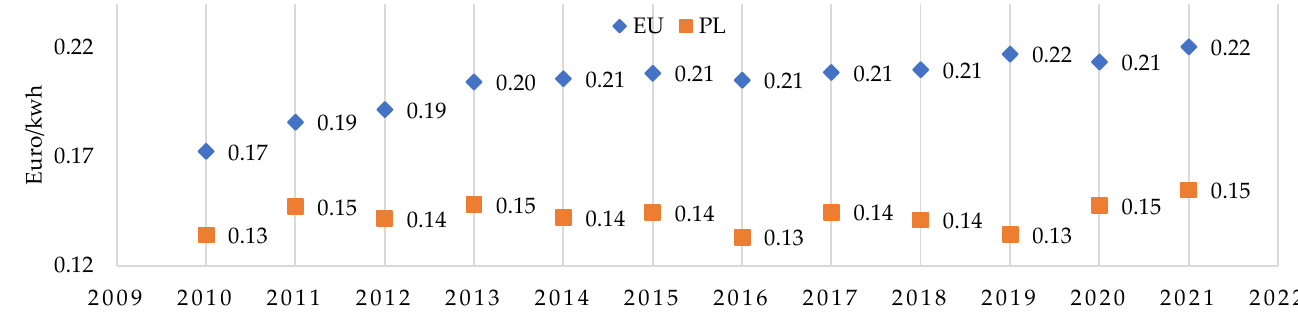
Figure 2. The structure of final energy consumption in households by type of fuel in Poland. Source: own elaboration based on EUROSTAT [40]. * Others—including: liquefied petroleum gases, ambient heat (heat pumps), other kerosene, solar thermal.